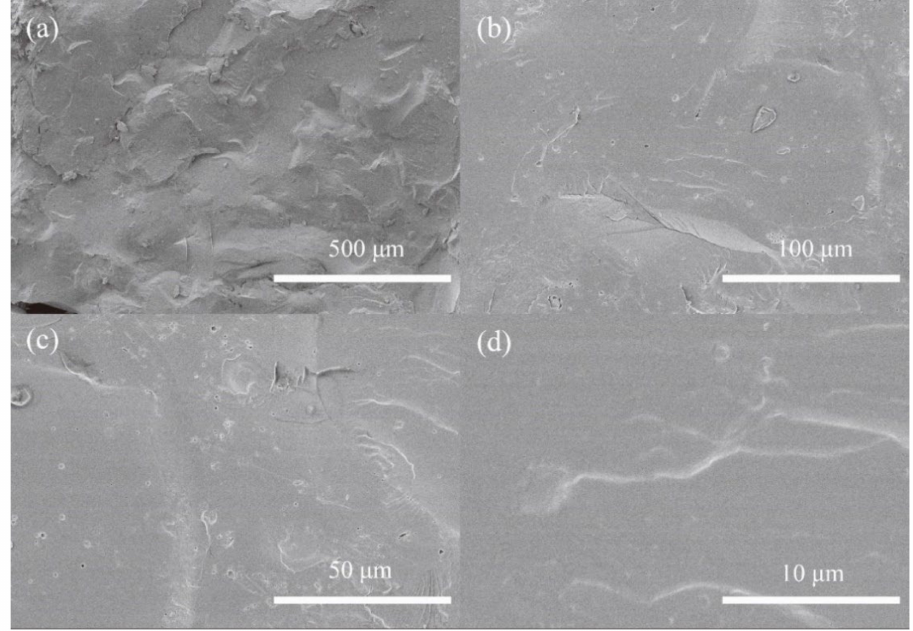
Figure 5. SEM images of semi IPNs 6%CPSFTPU 1 with different magnification times ( a ) 500 µ m; ( b ) 100 µ m; ( c ) 50 µ m; ( d ) 10 µ